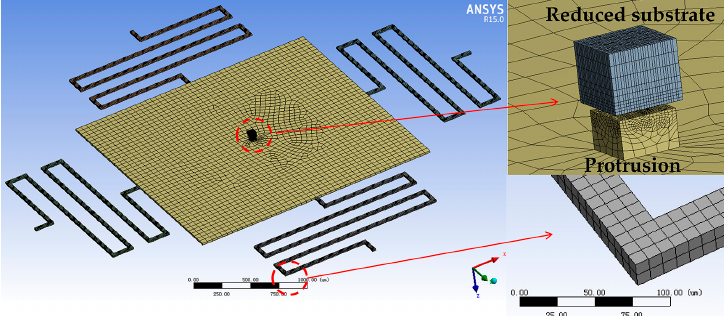
Figure 2. Finite element model of the micro-switch with the contact pair of the protrusion and reduced substrate.